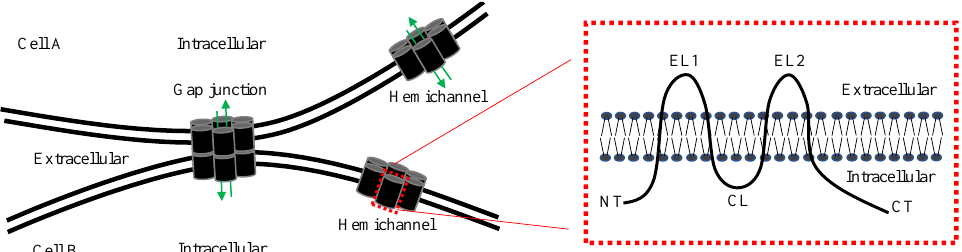
Figure 1. Schematic diagram of a gap junction, hemichannel and connexin. The membrane topology of a connexin protein is shown on the right. NT, N-terminal; EL, extracellular loop; CL, cytoplasmic loop; CT, carboxyl terminal. Green arrows indicate the gap junction and hemichannel pores that allow the passage of small molecules.